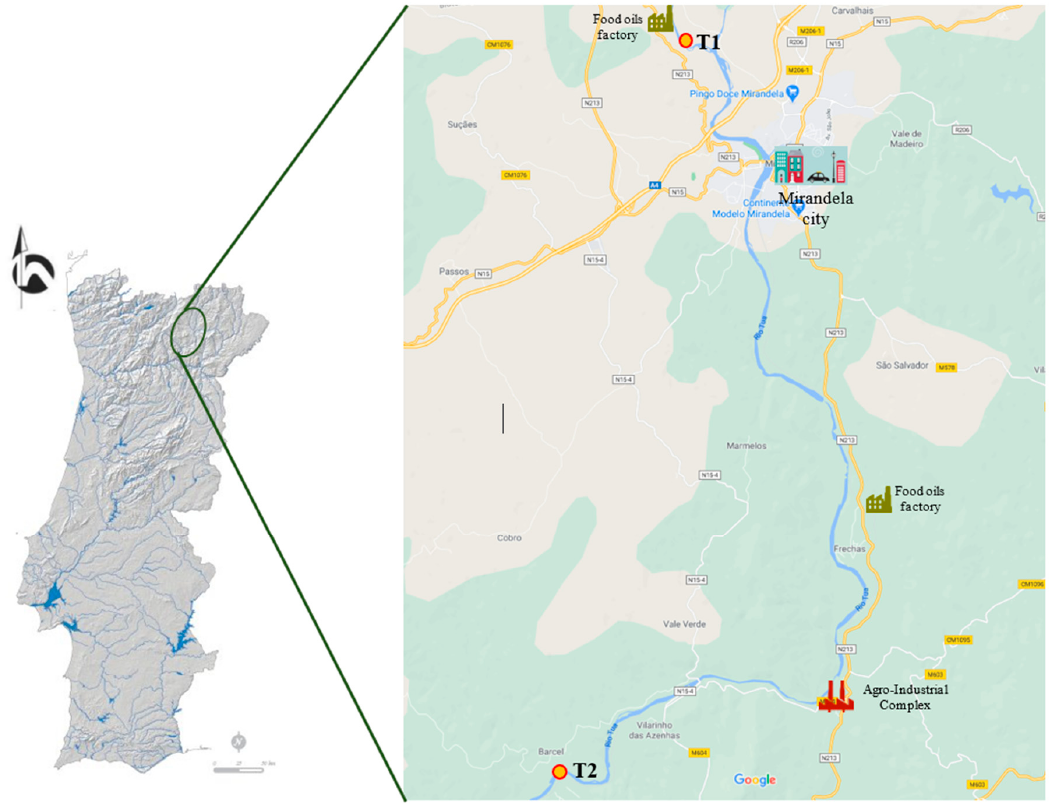
Figure 1. Map of the study area and the location of the two sampling sites (T1 and T2) in the Tua River basin. The water samples were collected in two different seasons (summer and autumn).